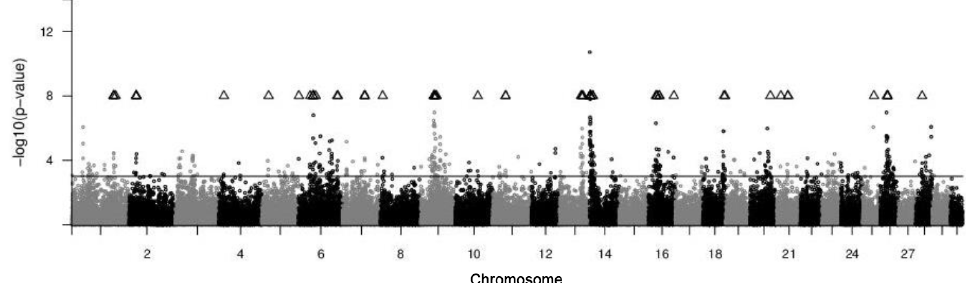
Figure 2. Test statistics of a single-marker GWAS for the trait milk protein yield in a sample of the German Holstein population. The solid line corresponds to a significance level of P = 0.001. Significant SNPs are indicated by triangles (taken from Streit et al.,